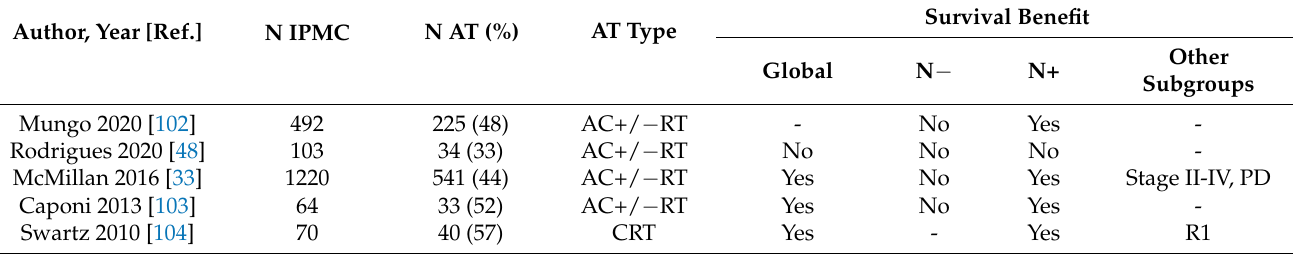
Table 4. Main studies evaluating adjuvant therapy in IPMC patients using multivariate analysis. Author, Year